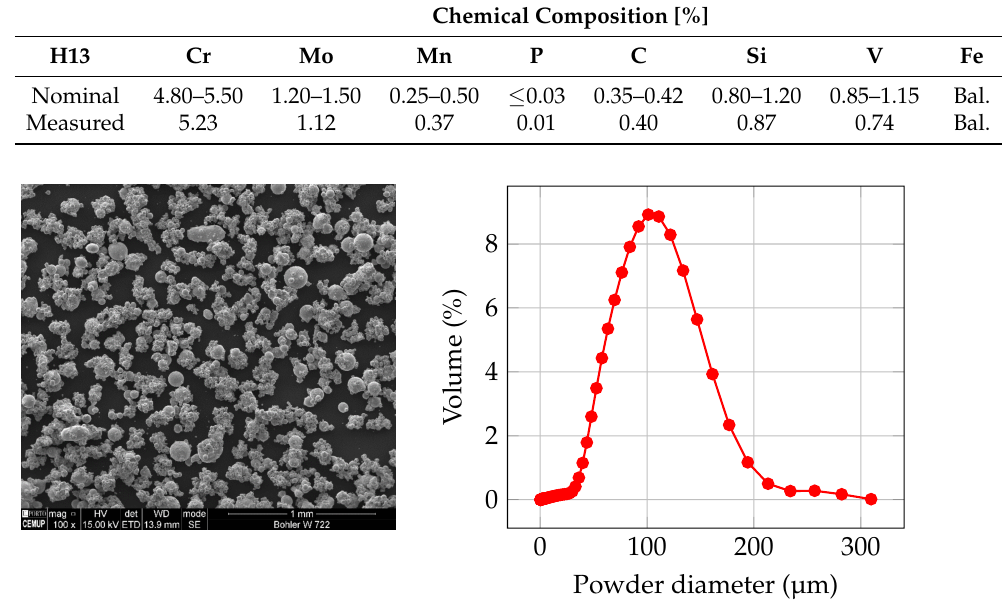
Figure 2. Powder morphology obtained through SEM, and its size distribution calculated through DLS.